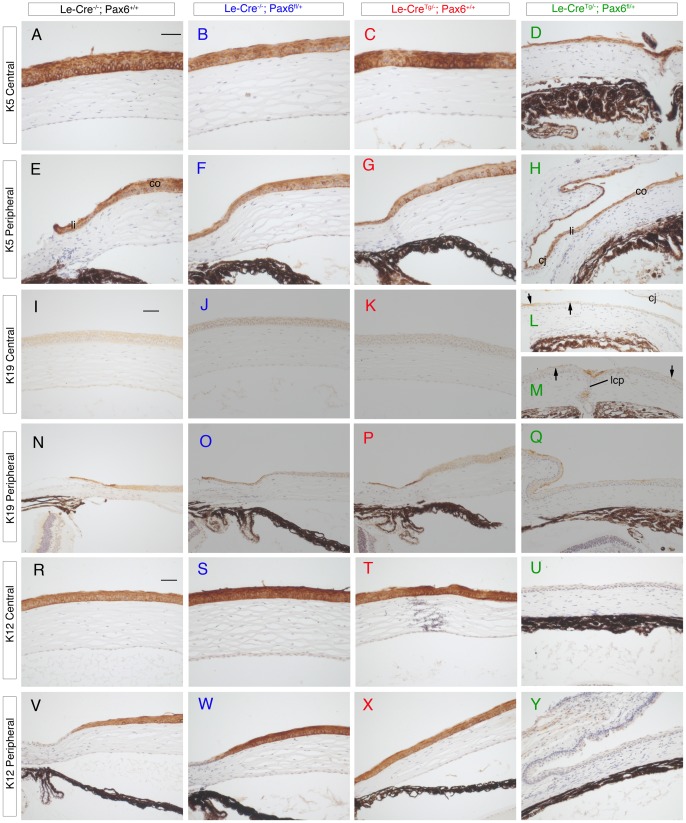
Immunohistochemistry for keratins 5, 19 and 12 in epithelia of the adult ocular surface of four genotypes from Le-CreTg/−; Pax6+/+ × Le-Cre−/−; Pax6fl/+ crosses in stage 1.(A–H) Keratin 5 (K5) immunostaining (brown endpoint) shows K5 is present in the central (A-D) and peripheral (E–H) corneal epithelium of all four groups. (I–Q) K19 immunostaining (brown endpoint) in the central corneal epithelium (I–M) shows K19 is absent in the three control groups (I–K) but patchy staining (arrows) is present in the Le-Cre−/−; Pax6fl/+ central corneal epithelium (L,M). The cornea shown in M has a lens-corneal plug. In the peripheral corneal epithelium (N–Q), K19 is present in some cells of the limbus (and conjunctiva) in all four groups. (R–X) K12 immunostaining (brown endpoint) in the central corneal epithelium (R–U) and peripheral corneal and limbal epithelium (V–Y) shows K12 is absent from the Le-CreTg/−; Pax6fl/+ ocular surface epithelium (U,Y) but present in the corneal epithelium of all three control groups (R–T and V–X). Scale bars  = 50 µm. Abbreviations: co, cornea; cj, conjunctiva; lcp, lens-corneal plug; li, limbus.